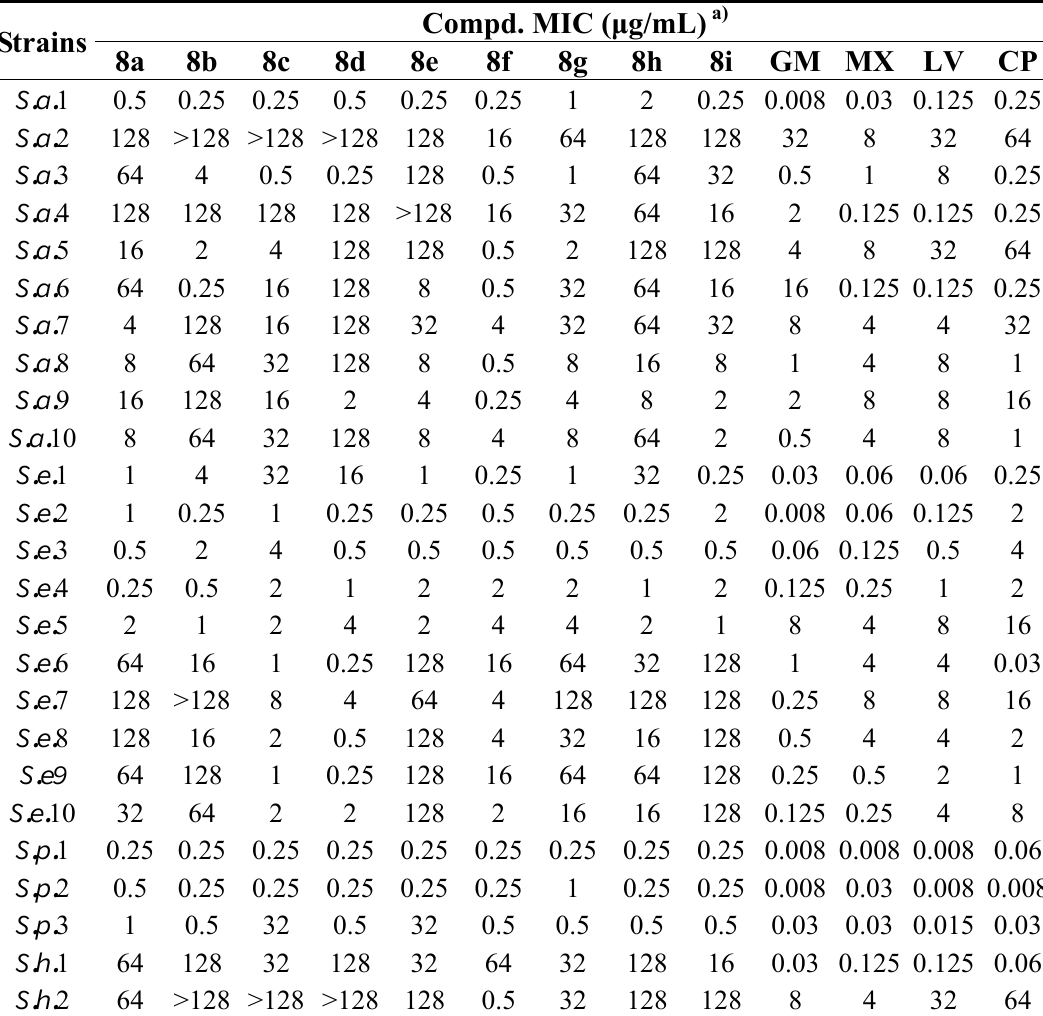
Table 1. In-vitro antibacterial activity of compounds 8a-i